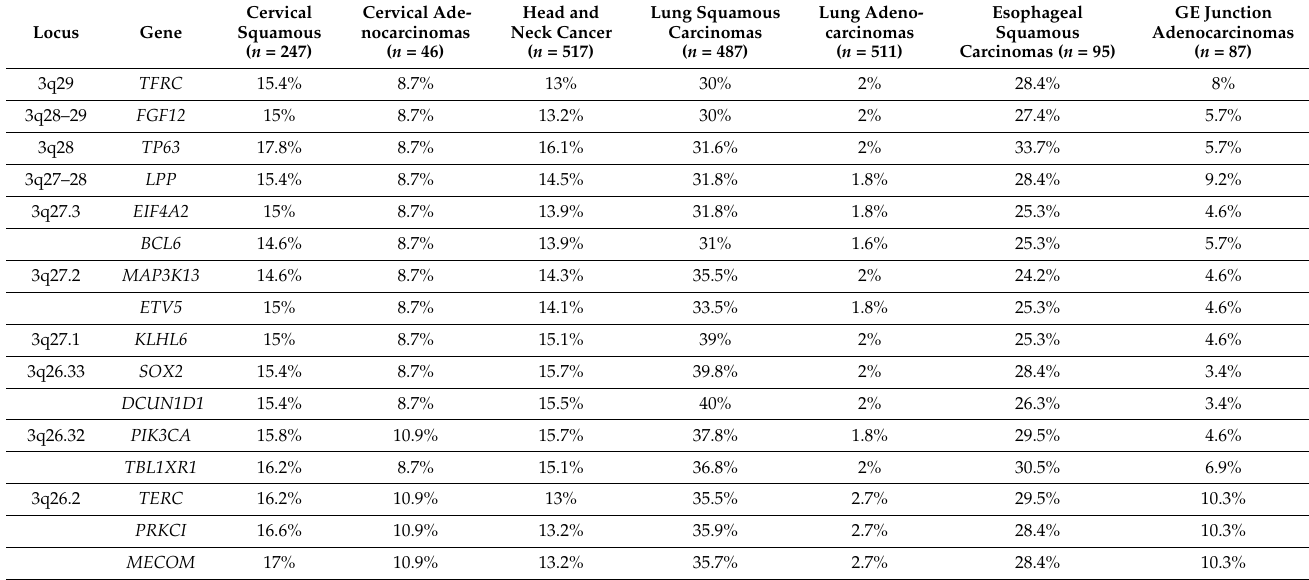
Table 2. Percentage of amplification of OncoKB listed genes at 3q26–29 in different cancers. Data are from TCGA cohorts. GE: